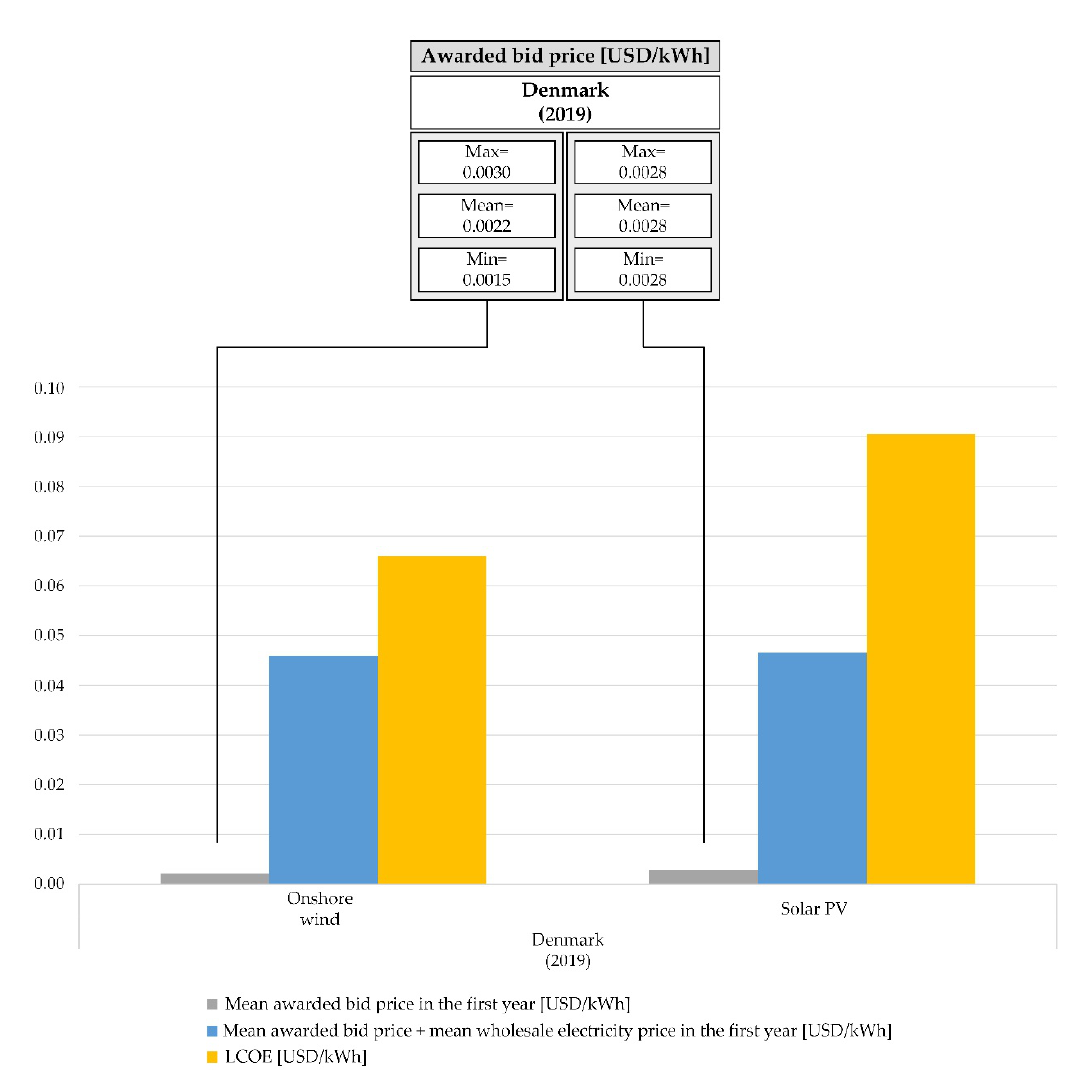
Figure 2. LCOE (yellow bars) versus mean awarded bid price under the fixed feed-in premium (FIP) scheme (grey bars) and mean awarded bid price added to the mean wholesale electricity price in the first year (blue bars) for the auctions from Denmark listed in Table 1. Source: self ‐elaboration.